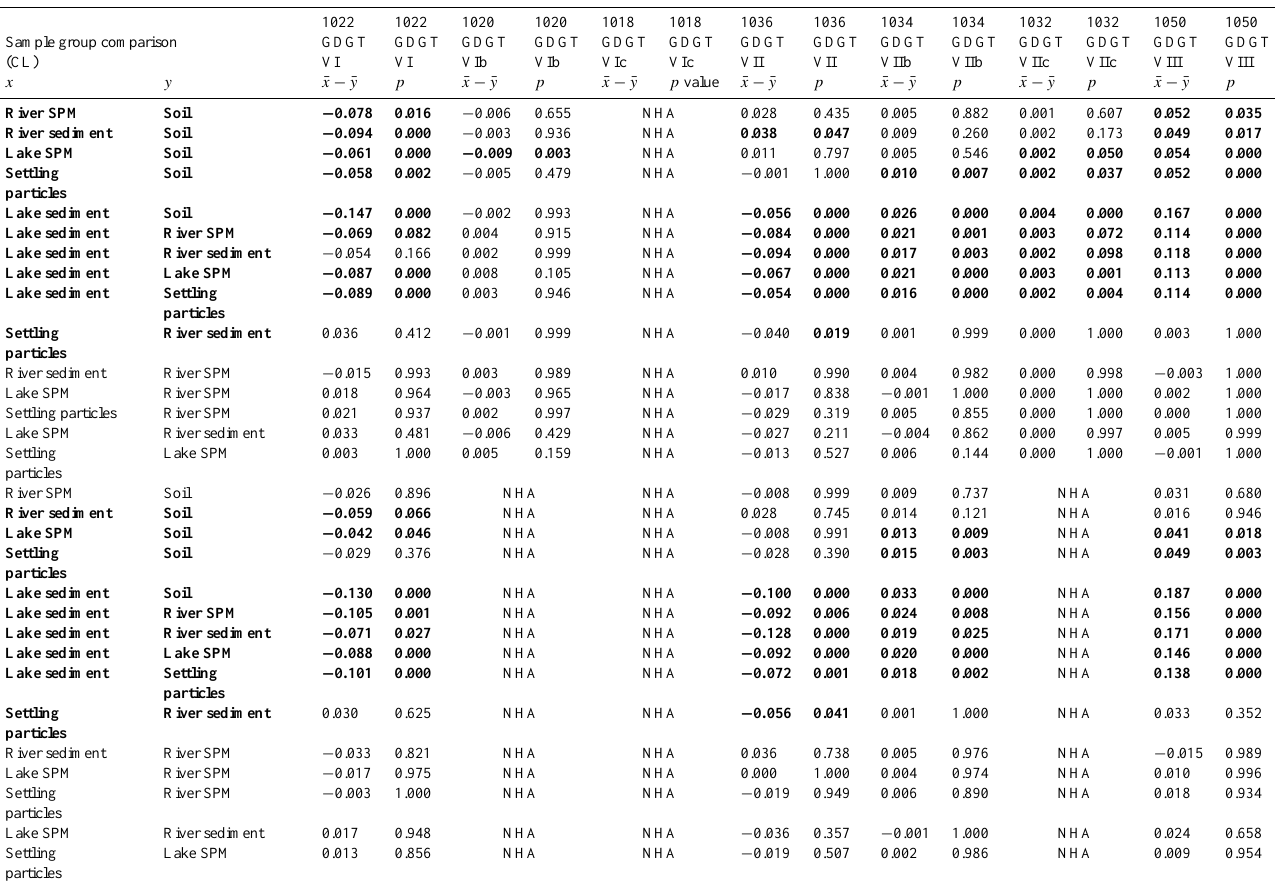
Table A1. Results of a MANOVA analysis (multivariate analysis of variance) and subsequent Tukey’s HSD procedures. The mean difference between sample groups (in units of fractional abundance) and associated p values are shown here for each brGDGT; where the null hypothesis was accepted (denoted NHA), no Tukey’s HSD procedures were performed. Samples and numbers in bold denote statistically significant differences ( p < 0 .